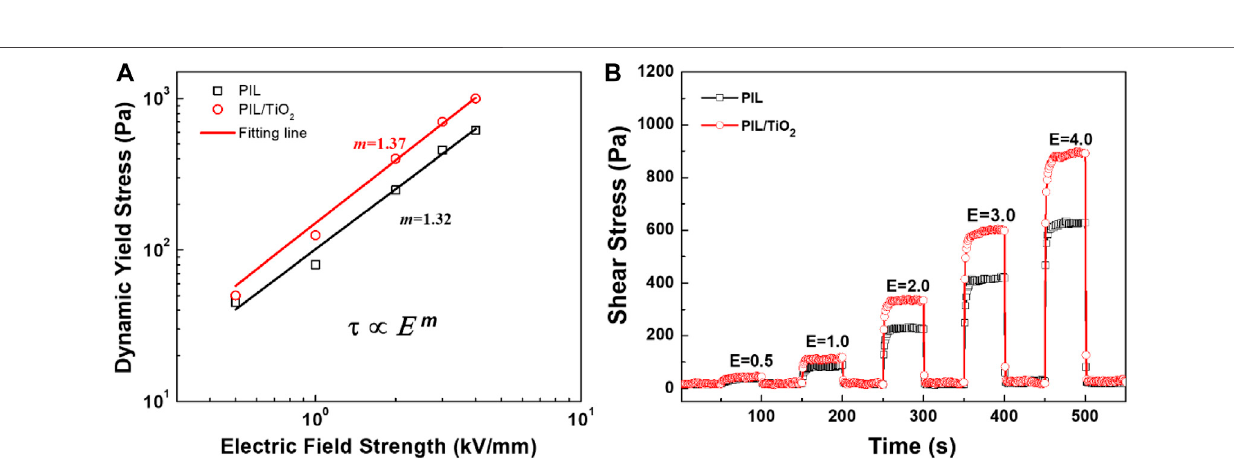
Frontiers in Materials |